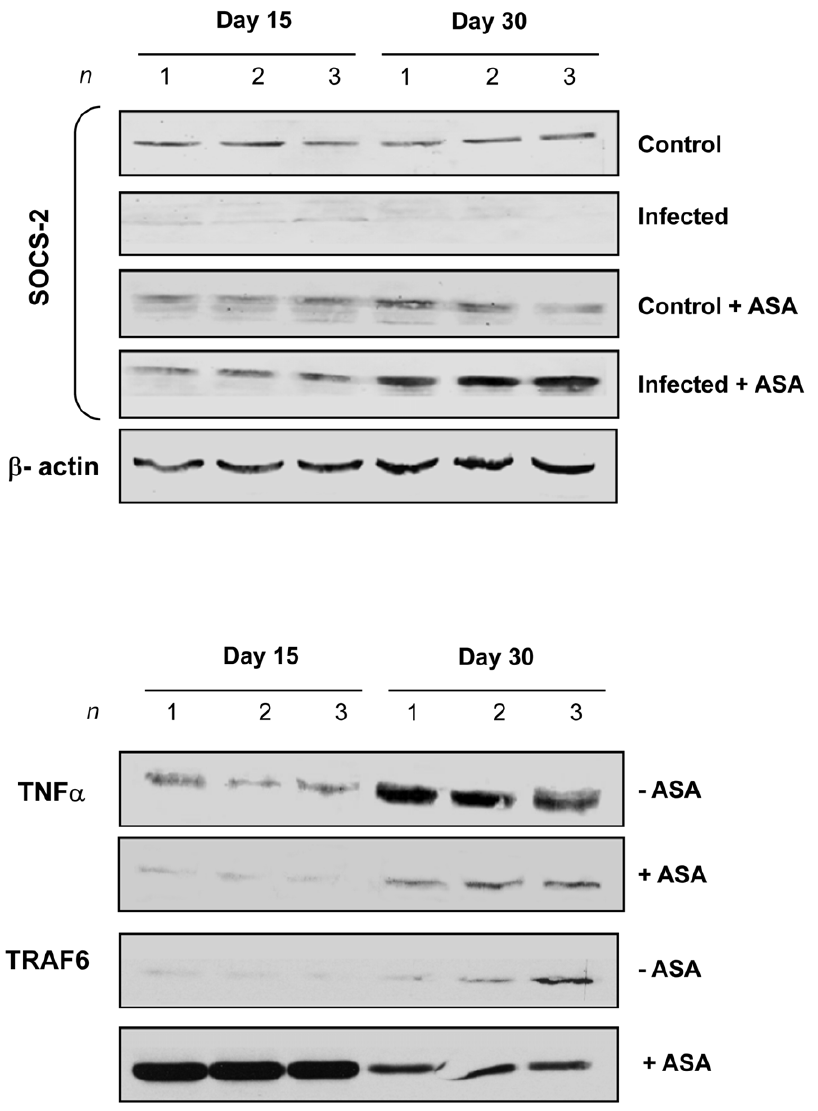
Figure 6. Treatment of T.cruzi- infected mice with ASA modulates cytokine signaling in the spleen of infected mice. Splenic extracts were prepared from uninfected and infected CD1 mice treated with ASA (20 mg/kg) from 5 dpi. Immunoblotting for TNF- a , SOCS-2 and TRAF-6 was performed on 15 and 30 dpi. b -actin was used as a loading control. Immunoblots are representative from at least three separate experiments.